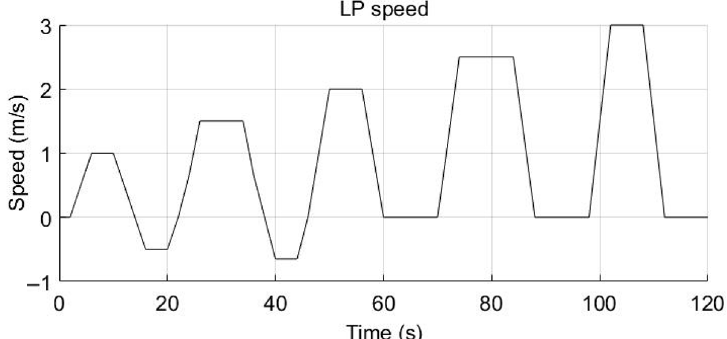
Figure 2 The LP speed vLP for parameter